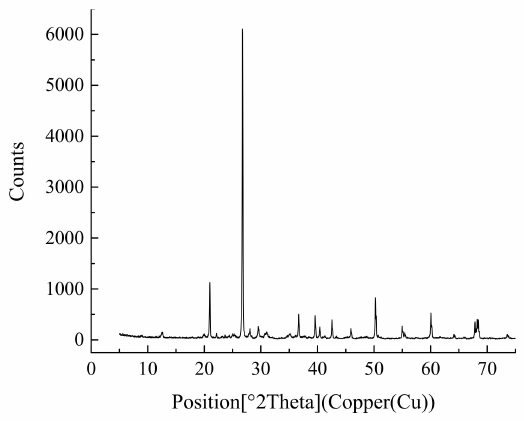
Figure 1. X-ray diffraction